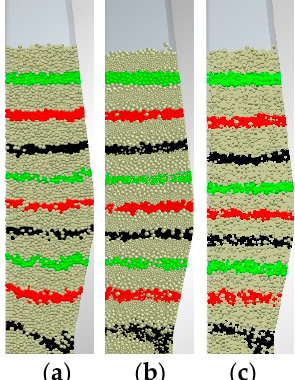
Figure 4. Internal wall of solid flow under three burden layer conditions simulated by the sector model 1 via DEM, i.e., full coke ( a ), layered coke and ore pellet ( b ) and mixed coke and ore pellet ( c ).